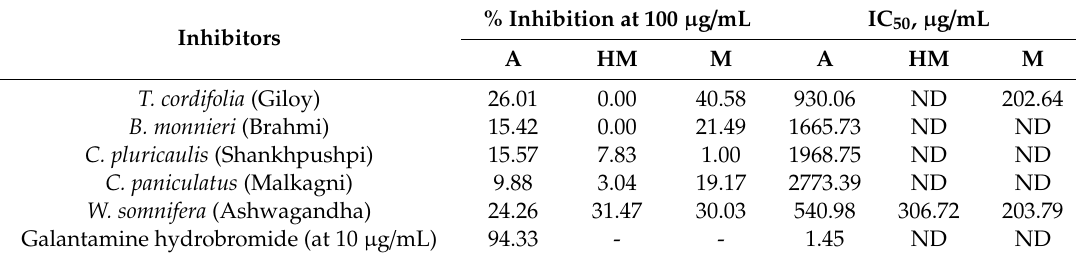
Table 1. Screening and IC 50 determination of herbal extracts against AChE.